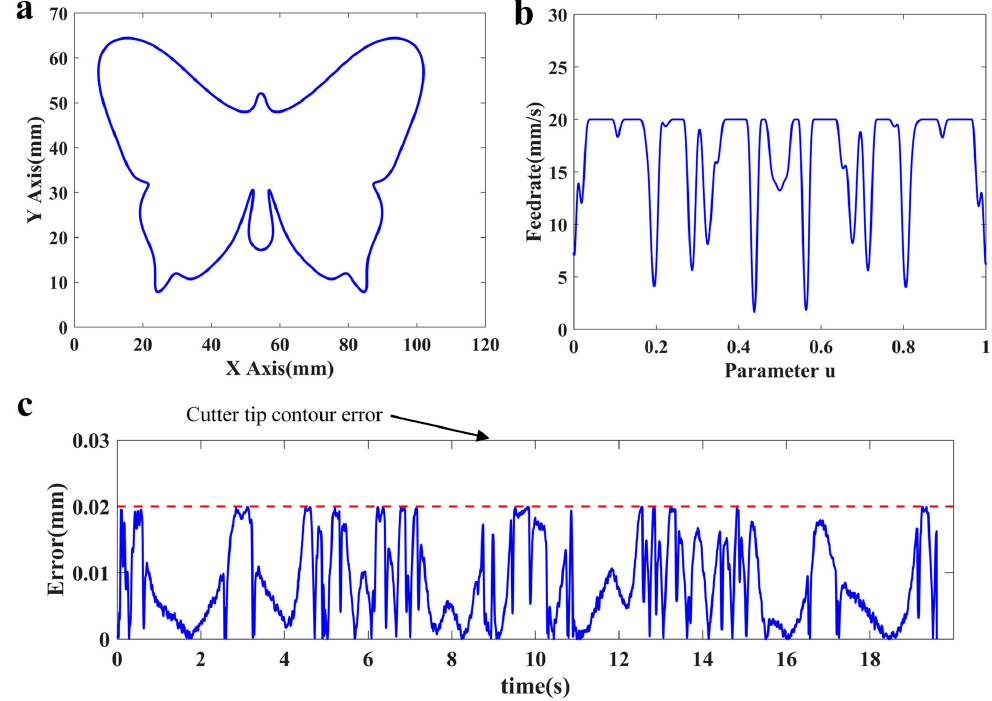
Figure 7. Experimental verification of butterfly trajectory: ( a ) butterfly trajectory; ( b ) feedrate curve generated by the proposed optimization algorithm; ( c ) experimental measurement results of cutter tip contour error.